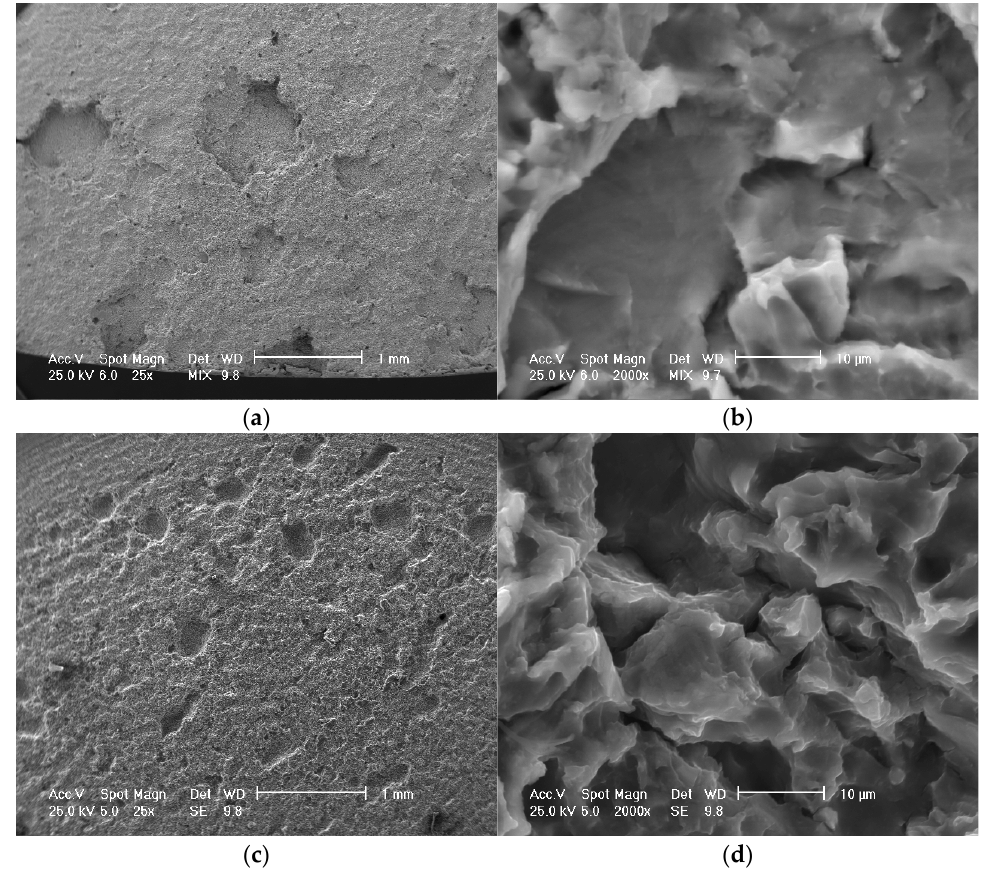
Figure 14 . Scanning electron analysis (SEM) of the eroded surfaces of alloy 5083, in cast state ( a , b control sample), and after quenching at 450 ℃ maintaining 100 min/air cooling and ageing at 180 °C/12 h at different magnification of the microscope ( c , d ): ( a , c ) macroscopic aspect, ( b , d ) microscopic aspect (detail of an image) . Table 6. Maximum depth of penetration of cavitation attack of 5083 aluminum alloy specimens in different heat treatment conditions.